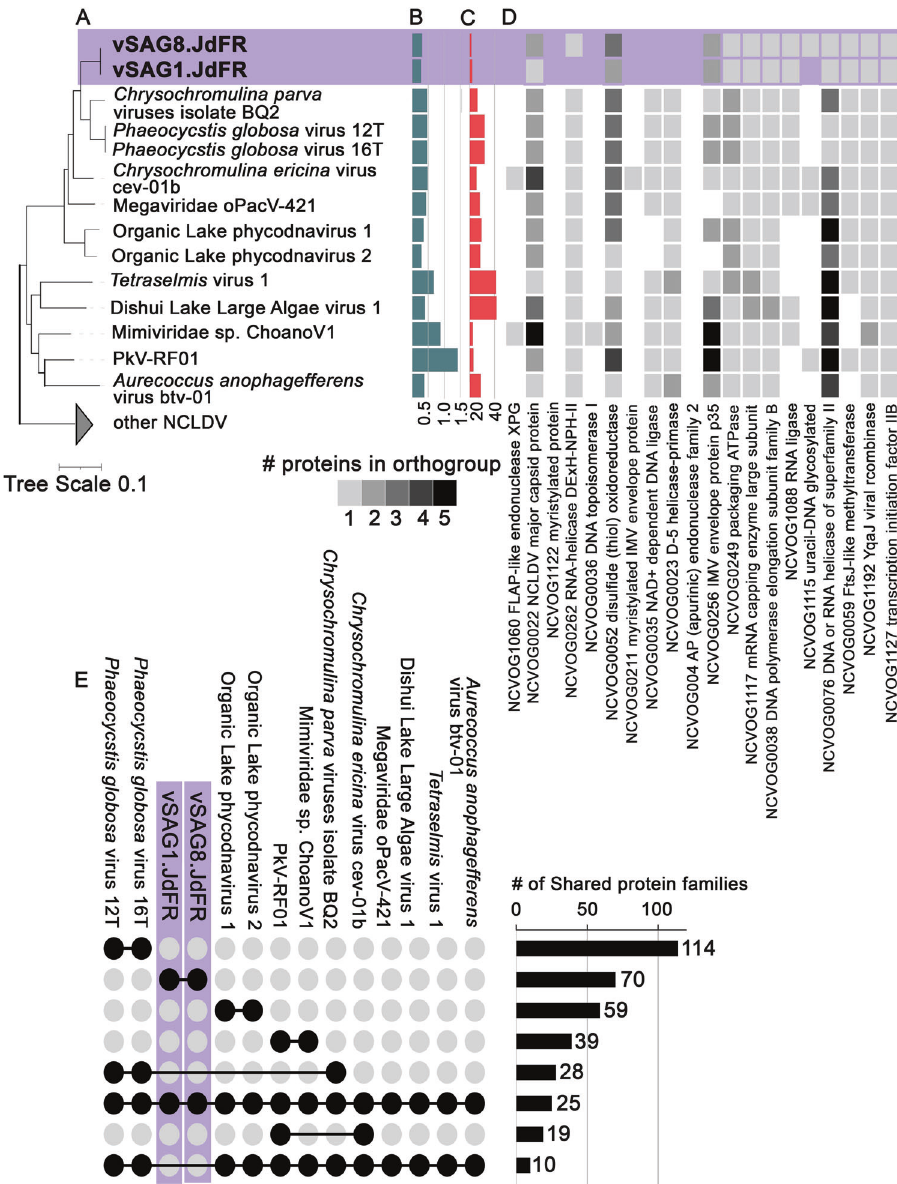
Fig. 2 Phylogeny, genome characteristics, and genes identi fi ed in giant fungal viruses in oceanic crust. A Phylogenetic position (maximum likelihood tree) of Juan de Fuca Ridge viral single-ampli fi ed genomes (vSAG1.JdFR and vSAG8.JdFR) based on a concatenated alignment of fi ve core nucleocytoplasmic virus orthologous genes (NCVOGs) (1. DNA polymerase elongation subunit family B (NCVOG0038); 2. D5-like helicase-primase (NCVOG0023); 3. packaging ATPase (NCVOG0249); 4. Poxvirus Late Transcription Factor VLTF3-like (NCVOG0262), 5. DNA or RNA helicases of superfamily II (NCVOG0076)). The scale bar represents substitutions per site; ( B ) genome assembly sizes (Mbp); ( C ) number of NCVOGs identi fi ed in each genome; ( D ) heatmap of protein copy number of genes mapped to the twenty ancestral NCVOGs. Presence/ absence and protein copy number patterns of these genes compared to closest related viruses in the phylogenetic tree are indicative of genome completeness; ( E ) number of protein families shared between selected members of the mesomimiviruses. Each set of compared genomes is displayed as solid circles connected by horizontal solid lines; the number of shared protein families and total number of distinct protein families in each lineage are shown as bars. eukaryotic gene sequences (Fig. S5A, B) in both metagenomes (Fig. S5A). Ascomycota were also present in the U1362A were af fi liated to plants, algae, and animals, none of which are metagenome [3, 22] in relatively high abundance, although expected to be able to live under the environmental conditions they did not comprise the majority of the identi fi ed eukaryotic of the igneous crust at this site. While it is possible that genes, and protein homology matches were lower than 90% eukaryotic environmental DNA that reaches the igneous crust (Fig. S5B). Furthermore, Ascomycota taxa were the only via recharge outcrops is preserved for some time, it is also eukaryotes that could be con fi rmed based on nearly complete possible that taxonomic af fi liation was skewed by current 18S rRNA gene (Table S2), partially complete 28S rRNA gene information in public databases and by the limited information (Table S10), and ITS sequences (Table S11) retrieved from the provided by the short sequence fragment ’ s length. metagenomes. Short 18S rRNA fragments (Table S2) and other